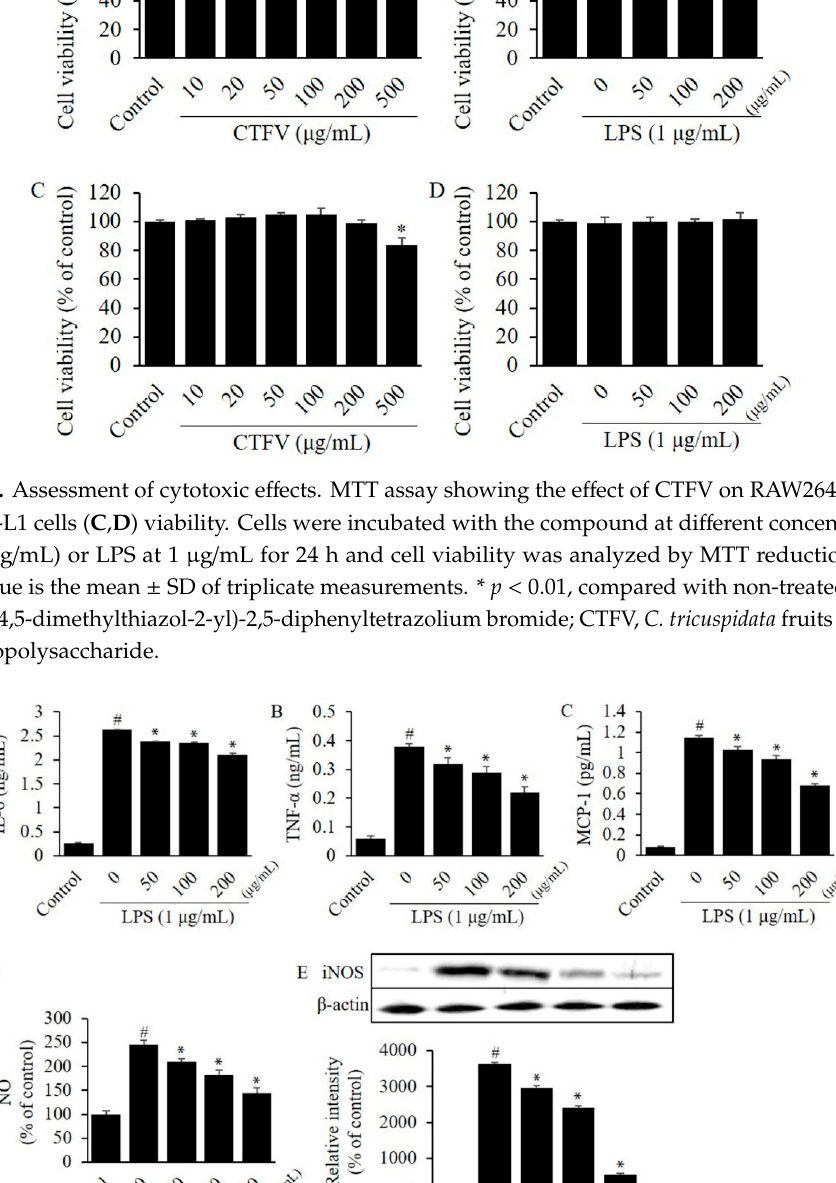
Figure 4. Effect of CTFV on the inflammatory response in 3T3-L1 cells. The levels of IL-6 ( A ), TNF- α ( B ), MCP-1 ( C ), NO ( D ), and iNOS ( E ) in 3T3-L1 cells were measured by ELISA, the Griess reagent, and western blot analysis. Measurement of these expression or levels in non-treated cells was used as the control group. Each value is the mean ± SD of triplicate measurements. # p < 0.01, compared with non-treated group. * p < 0.05 and ** p < 0.01, compared with only LPS-treated group. CTFV, C. tricuspidata fruits vinegar; IL, interleukin; TNF, tumour necrosis factor; MCP, monocyte